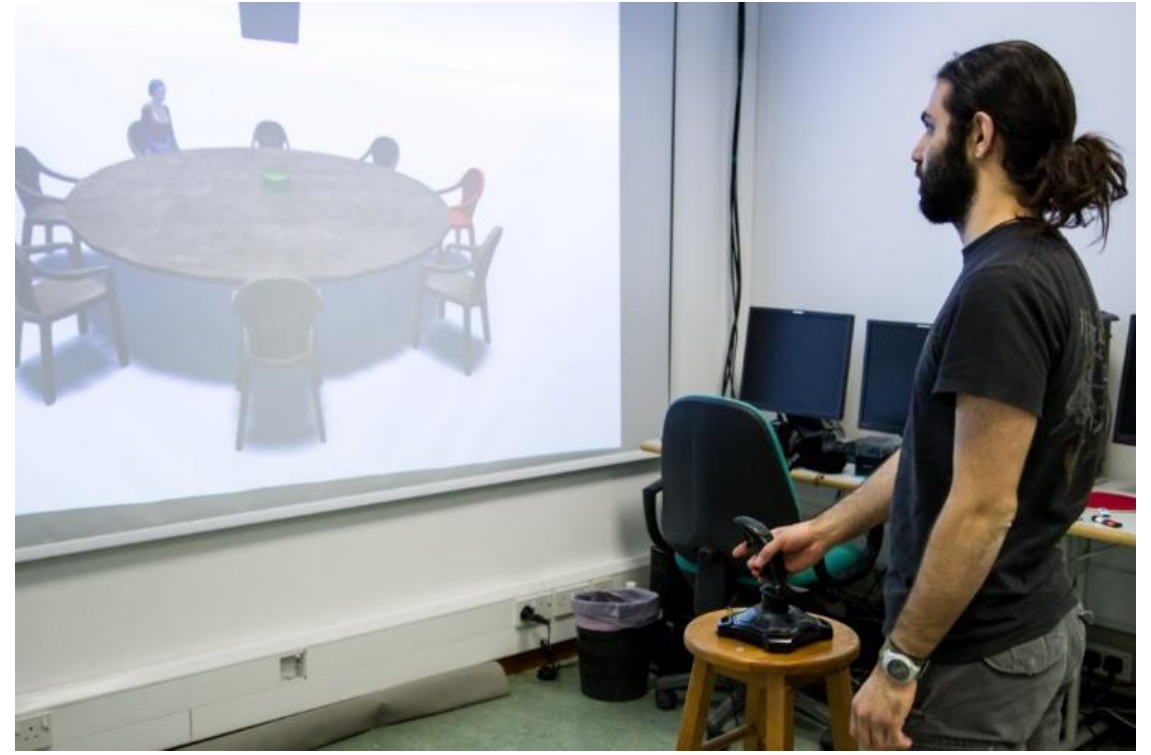
Figure 7. Example of a participant carrying out the task in the RE-Joystick condition of Experiment 3.